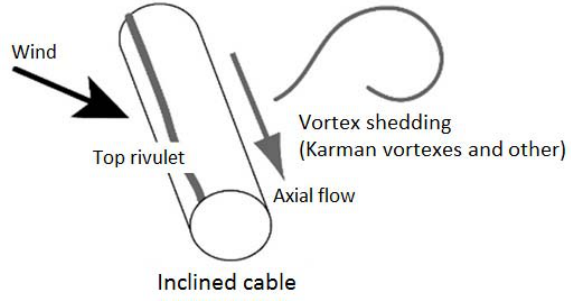
Fig. 8 . Factors considered in the aerodynamics of inclined cables